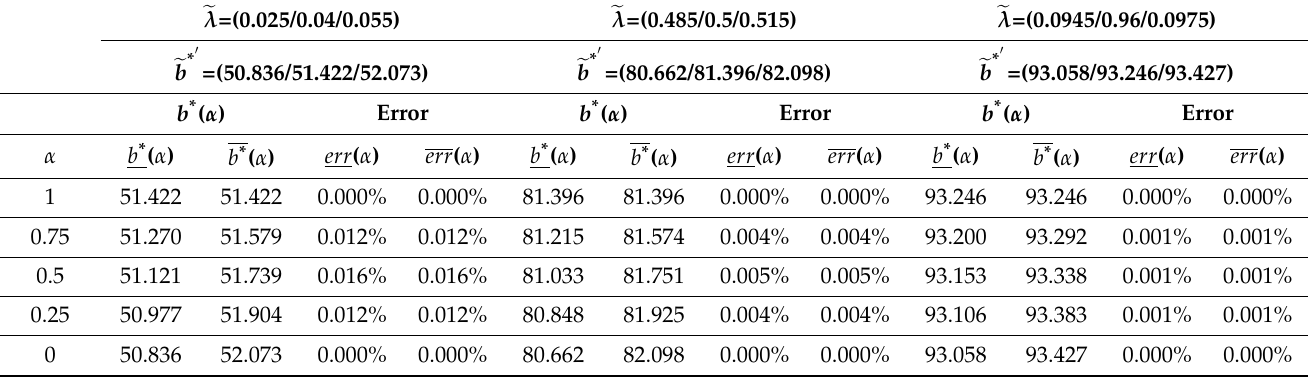
Table 8. α -cuts of (cid:101) b ∗ , it’s triangular approximate and errors for different parameters (cid:101) λ . (cid:101) λ